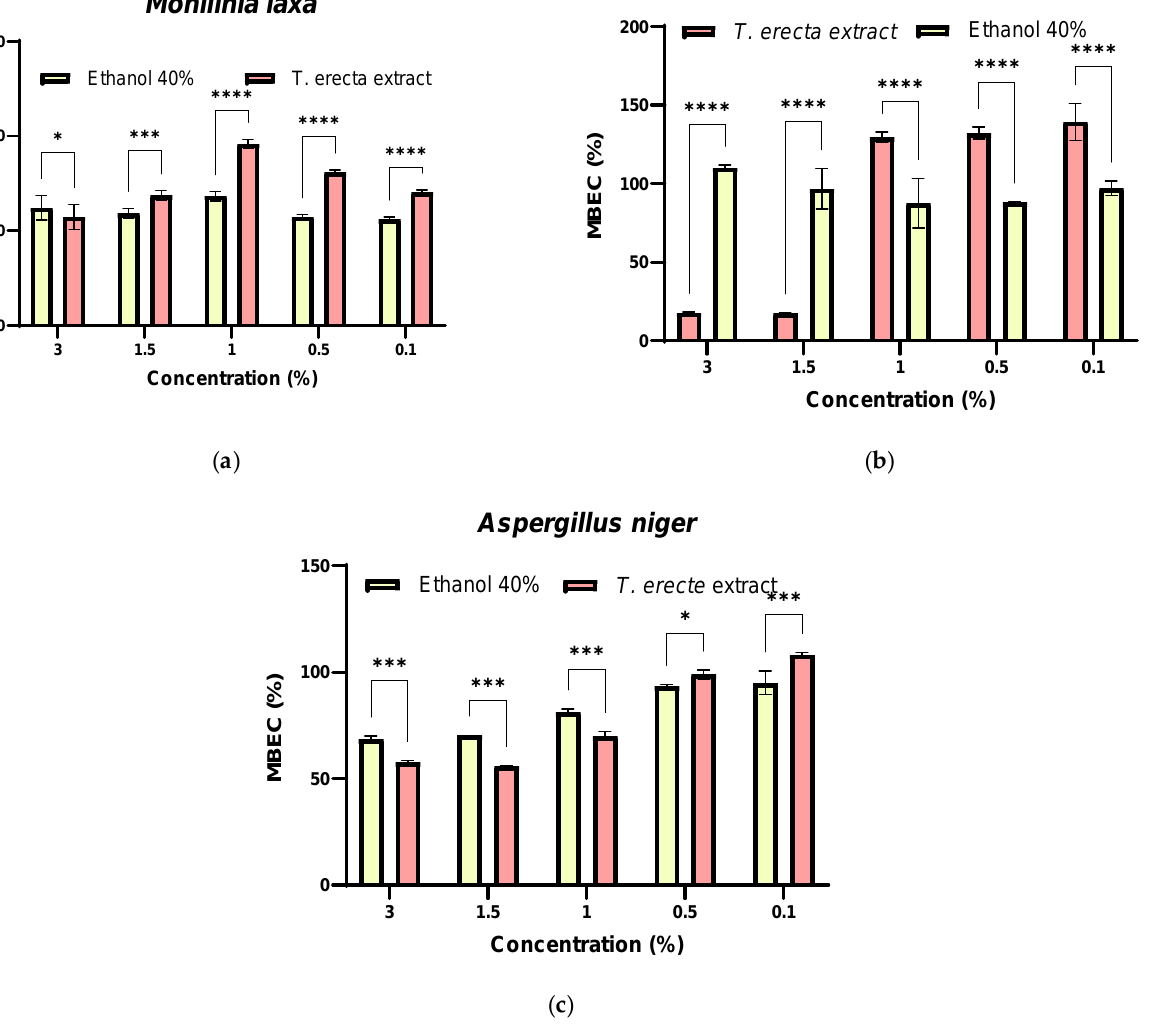
Figure 7. MBEC (%) values for T. erecta extract and the corresponding solvent concentration against phytopathogenic fungal strains: M. laxa ( a ), F. graminearum ( b ) and A. niger ( c ) (* p < 0.05, *** p < 0.001, **** p < 0.0001).